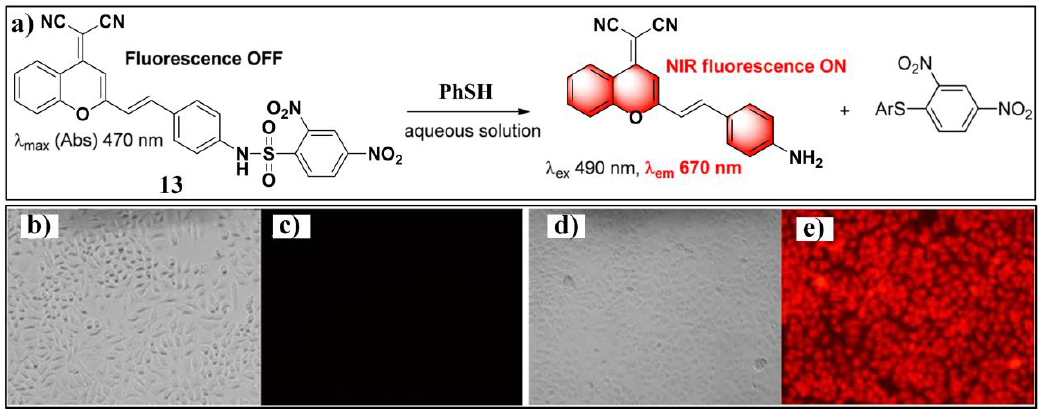
[80], 18 [80], 19 [81], 20 [82], and 21 [83]) were also constructed (Figure 8).